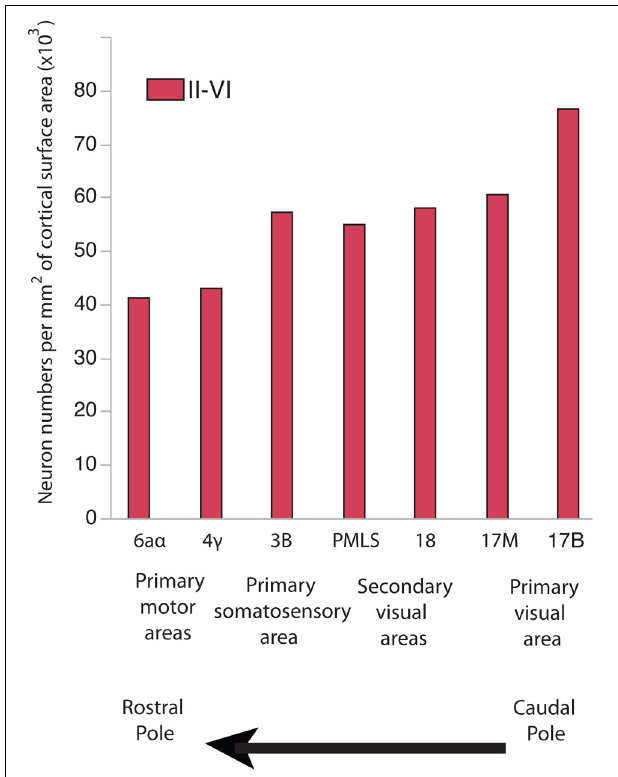
FIGURE 1 | Neuron numbers per unit of cortical surface area in different cortical areas in the cat. Neurons per unit of cortical surface area are high toward the caudal pole and systematically decrease toward the rostral pole. 17B and 17M stand for the binocular and monocular portion of area 17, respectively. PMLS: posteromedial suprasylvian area. These data are from Beaulieu and Colonnier